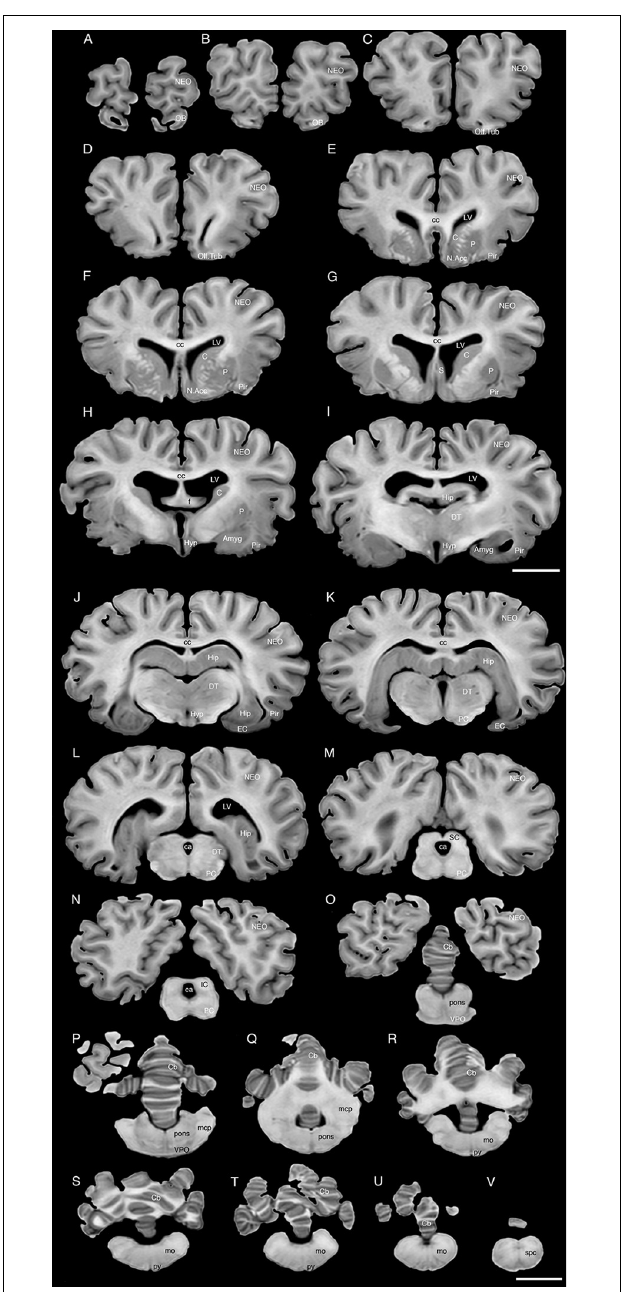
FIGURE 3 | A series of coronal structural MR images through the brain of the black rhinoceros ( D. bicornis ). (A) is the most rostral section and (V) is the most caudal section, with each section having a thickness of 2 mm and each section being 6 mm apart. Note the typically mammalian topography of the various regions and structures of the brain. Scale bar = 2 cm. Amyg, amygdaloid body; C, caudate nucleus; ca, cerebral aqueduct; Cb, cerebellum; cc, corpus callosum; DT, dorsal thalamus; EC, entorhinal cortex; f, fornix; Hip, hippocampus; Hyp, hypothalamus; IC, inferior colliculus; LV, lateral ventricle; N.Acc, nucleus accumbens; NEO, neocortex; mcp, middle cerebellar peduncle; mo, medulla oblongata; OB, olfactory bulb; Olf. Tub, olfactory tubercle; P, putamen; PC, cerebral peduncle; Pir, piriform cortex; py, pyramidal tract; S, septal nuclear complex; SC, superior colliculus; spc, cervical spinal cord; VPO, ventral pontine